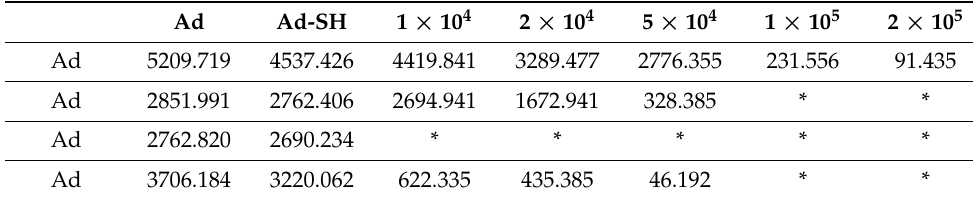
(* Asterisks denotes no bands or bands with poor